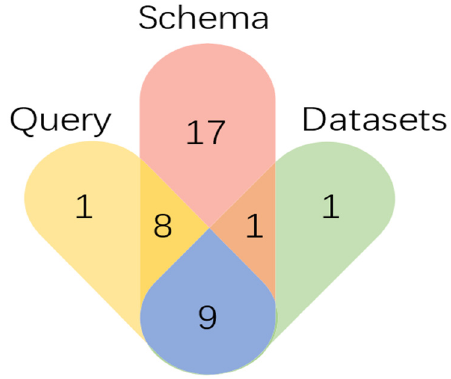
Figure 6. Equivalent entity types across schemas.